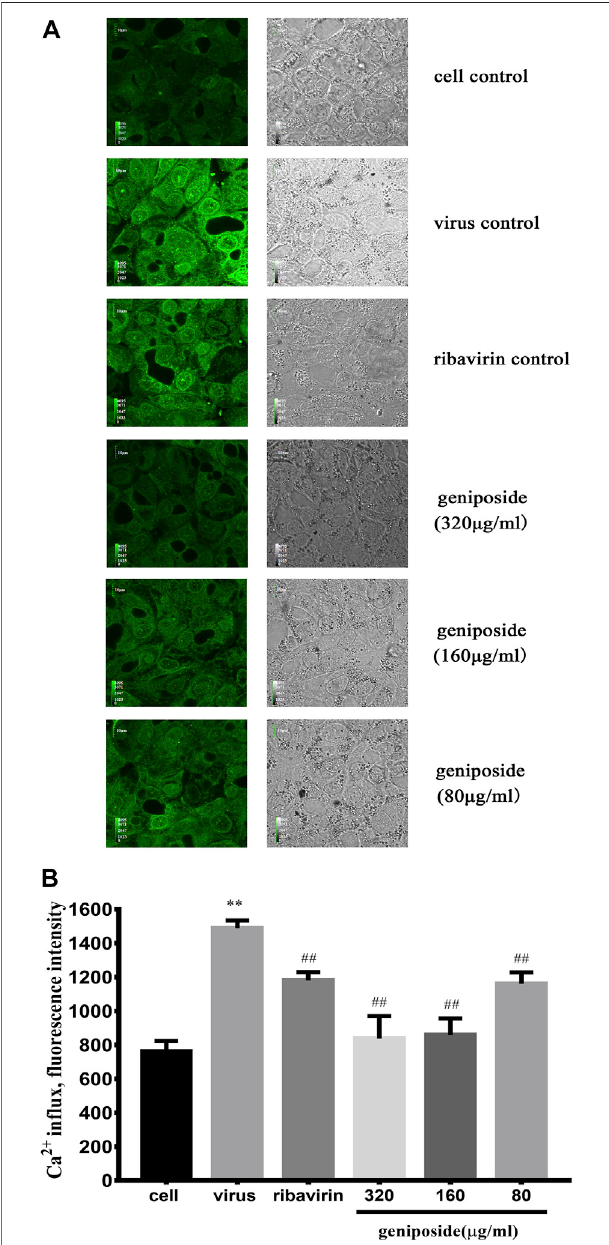
FIGURE 5 | Effect of geniposide on [Ca 2+ ]i levels in MDCK cells infected within fl uenzavirus.Valueswereexpressedasthemean fl uorescenceintensity of fl uo-3withfoursamplesineachgroup.Ineachsample,8randomlyselected fi elds were analyzed. (A) Confocal images of MDCK cells stained with fl uo-3 probe at 1 h post-infection. Green images represent fl uorescence images taken at emission of 530 nm. Grayscale images represent control images of MDCK cells without fl uo-3 staining. (B) The concentration of [Ca 2+ ]i was represented by mean fl uorescence intensity ( n (cid:1) 4). ** p < 0.01 compared to cell control group, ## p < 0.01 compared to infection control group (A color version of this fi gure is available in the online